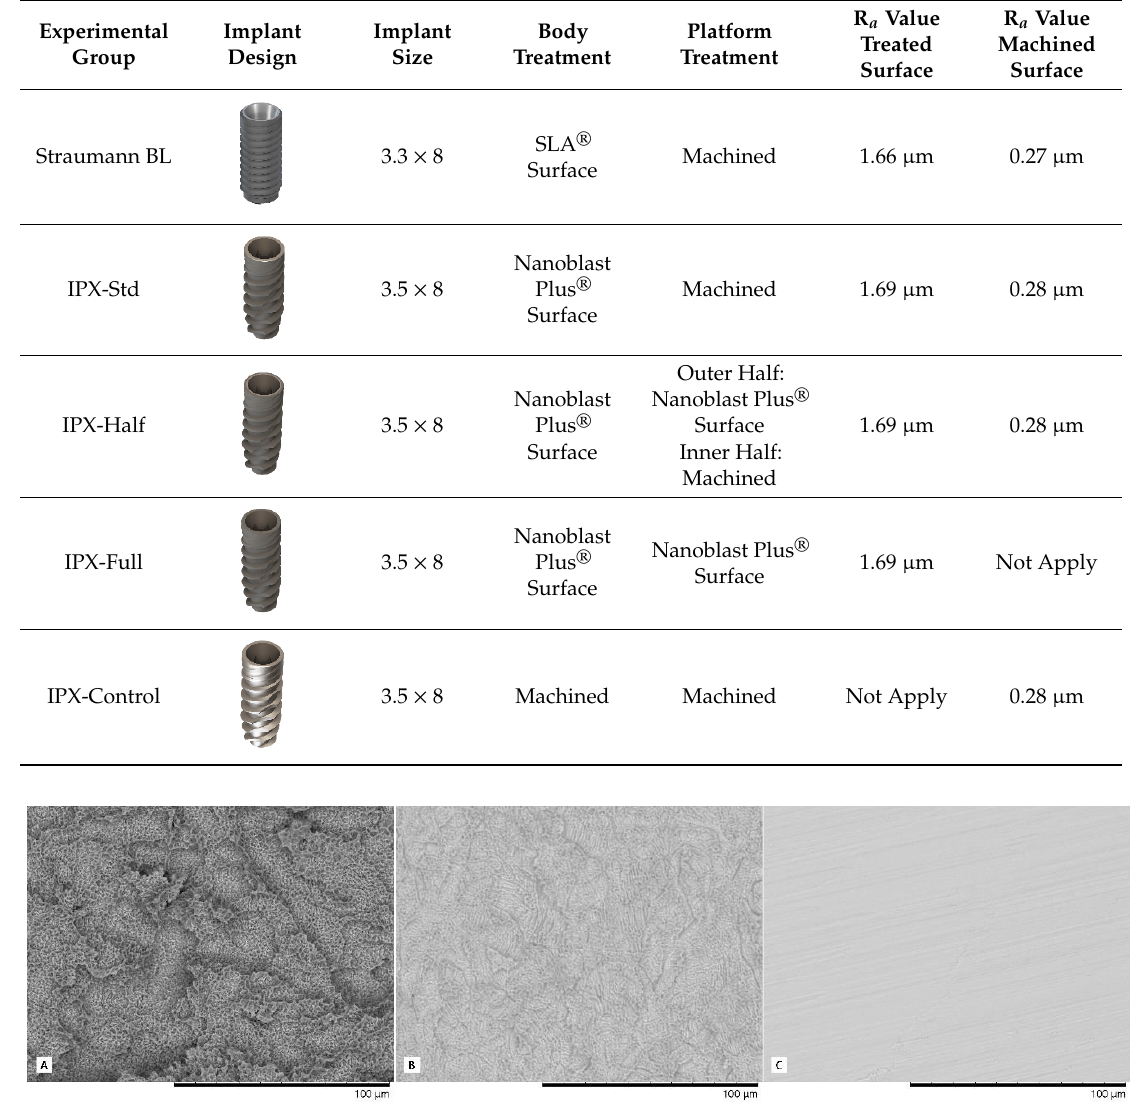
Figure 2. High magnification images (1000 × ) of the surfaces evaluated; ( A ) SLA ® Surface, ( B ) Nanoblast Plus ® Surface, and ( C ) IPX Machined Surface.